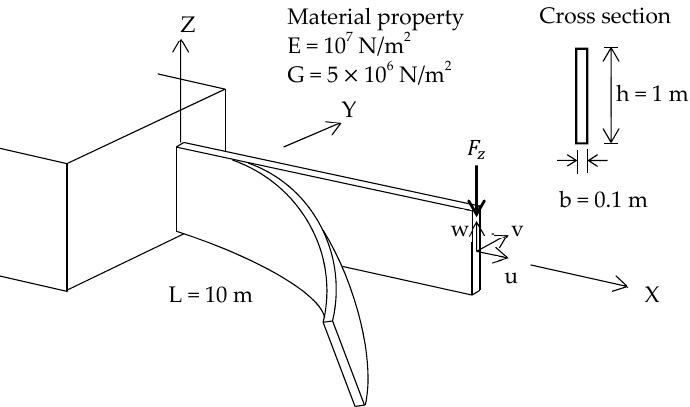
Figure 10. Lateral buckling of a cantilever beam subject to a downward concentrated load.